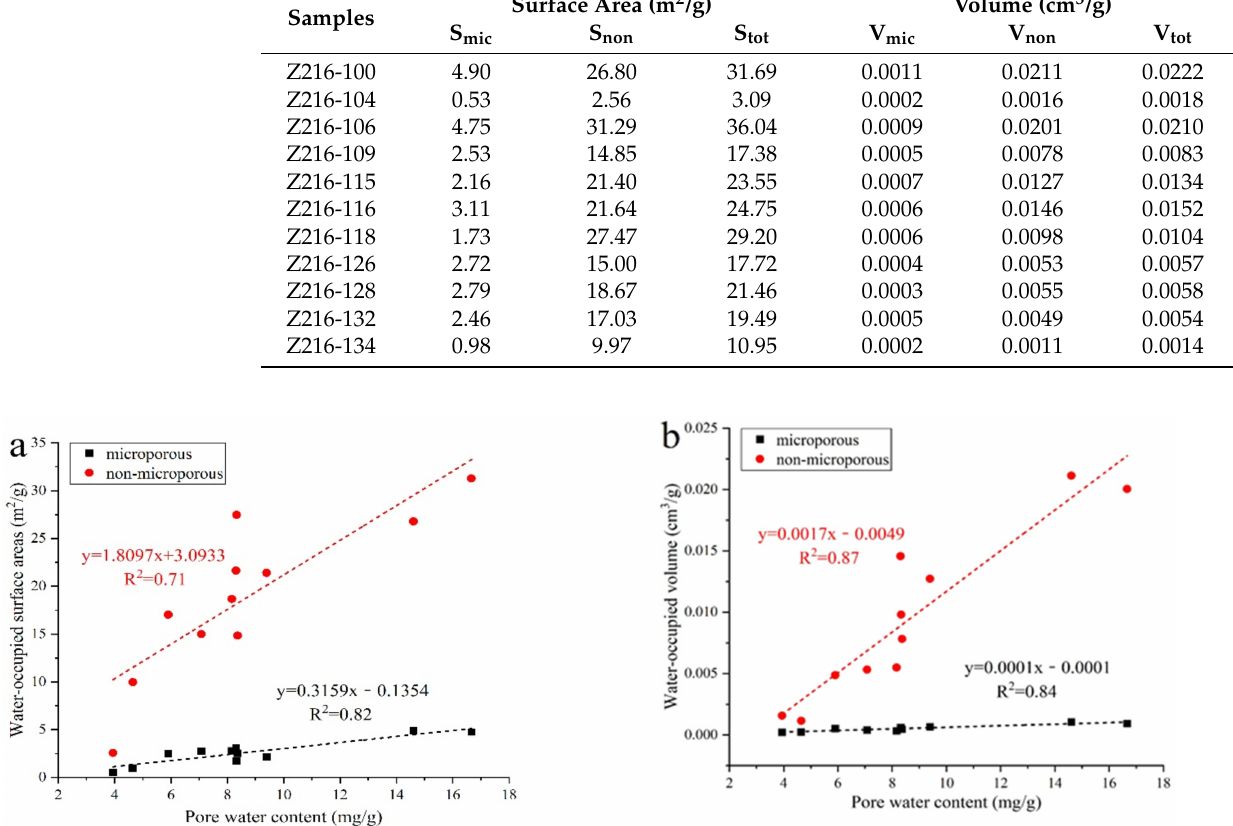
Figure 9. Relationships between water-occupied pore surface areas ( a ), volumes ( b ) and pore water content for the shale